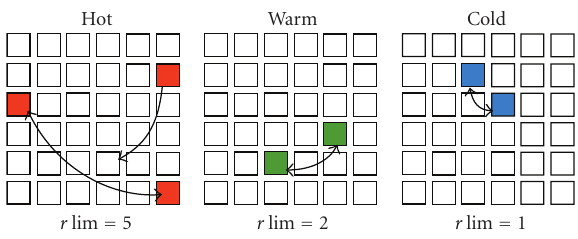
Figure 2: Illustration of how rlim controls moves inside the SA-based placement algorithm of VPR [12]. Initially, at high temperatures, blocks far away from each other can be easily swapped. Finally, at low temperatures, only blocks close to each other can be swapped.